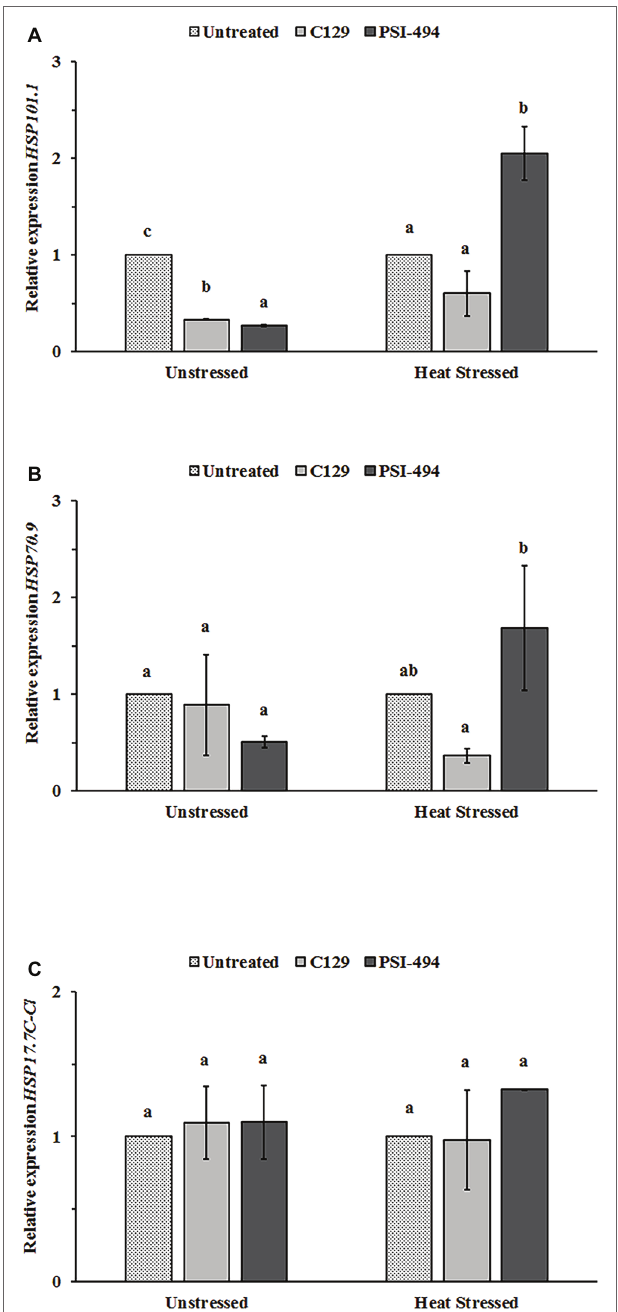
FIGURE 6 | Effect of heat stress and ANEs on HSPs gene expression in tomato flowers. (A) HSP101.1 ; (B) HSP70.9 ; and (C) HSP17.7C-Cl . Data were measured in 122-day-old plants and expressed as the relative fold- change with respect to the ACTIN2 ( ACT2 ) gene expression levels. Different letters within the same growth condition indicate statistically significant differences between the treatments based on one-way ANOVA Tukey’s HSD test at p ≤ 0.05. Number of biological replicates =